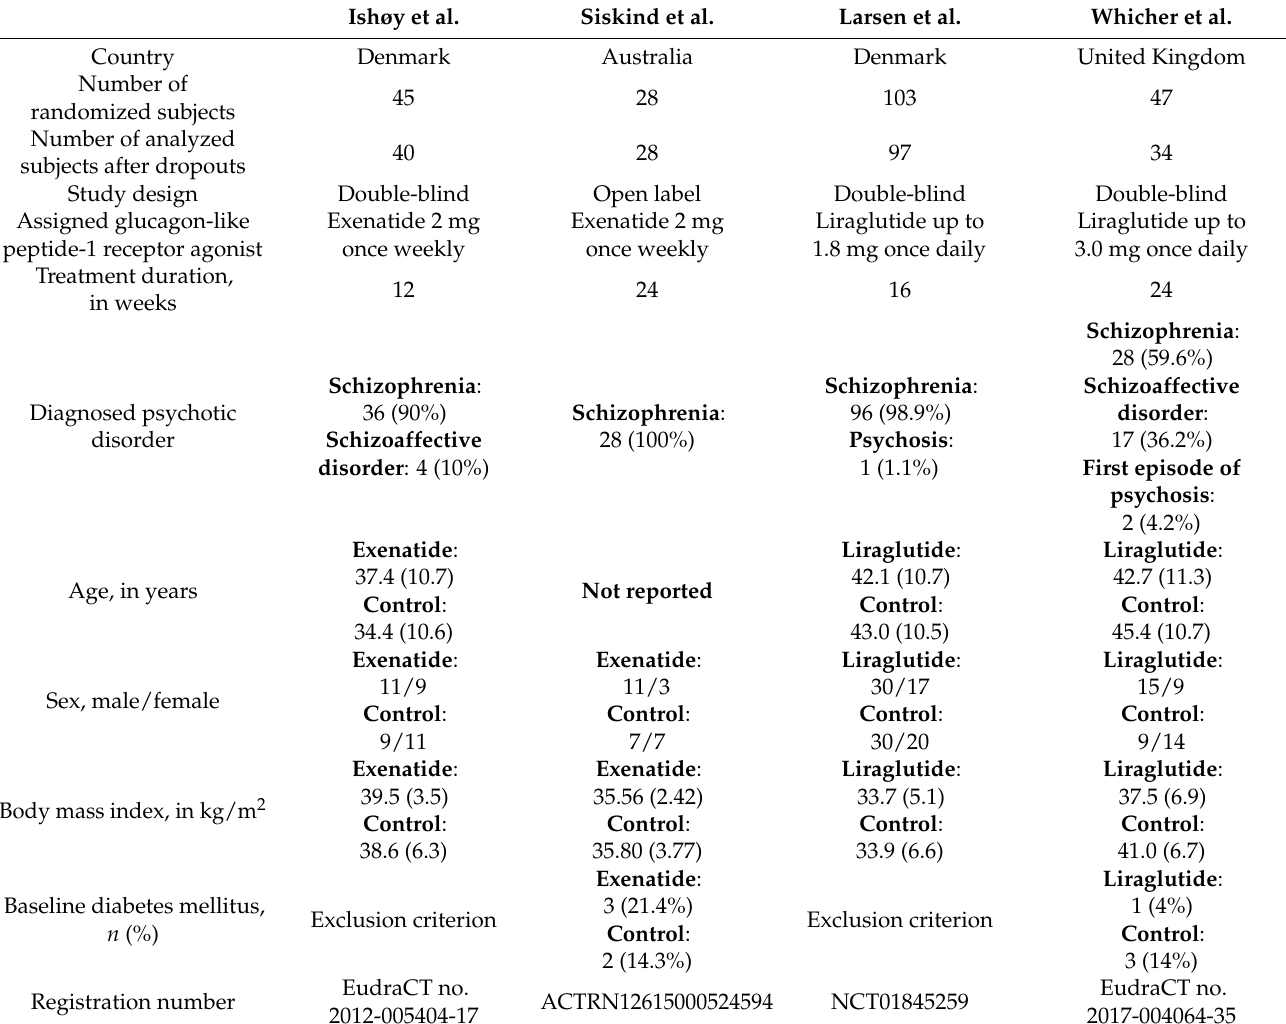
Table 1. Participants’ baseline characteristics across the eligible trials. Ishøy et al. Siskind et